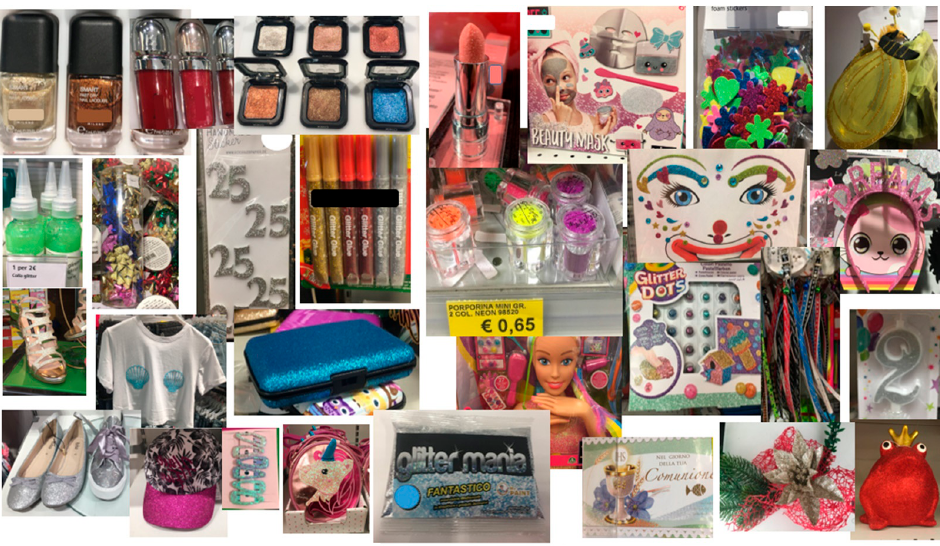
Figure 1. Photos of some products decorated with glitter, available on the local